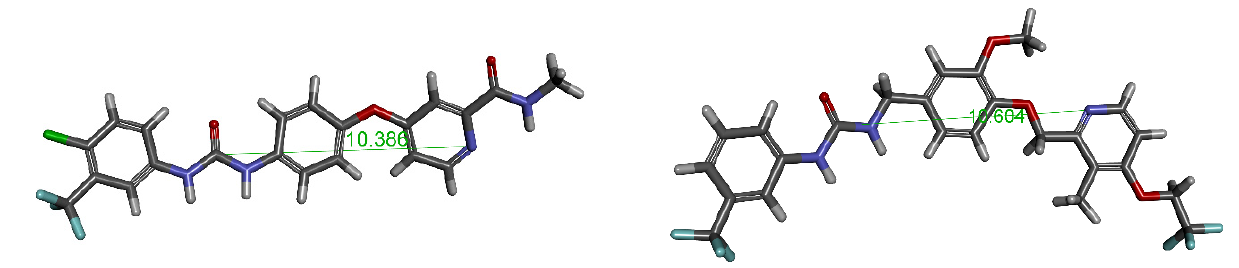
Figure 2. Spatial distance of the two nitrogen atoms in pyridine ring and urea moiety of sorafenib ( left ) and a target compound ( right ).